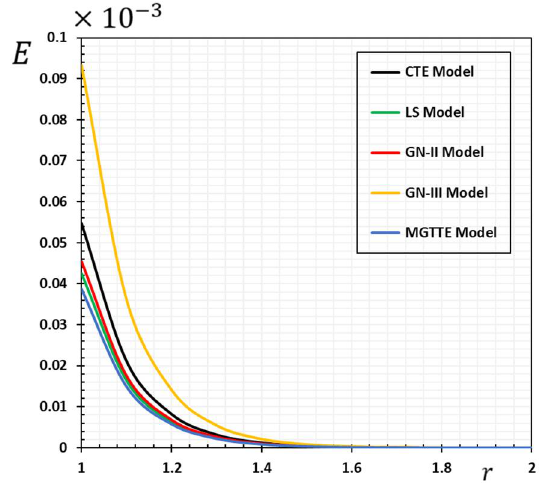
Figure 14. The induced electric field, (cid:1831) , versus different thermoelastic models.